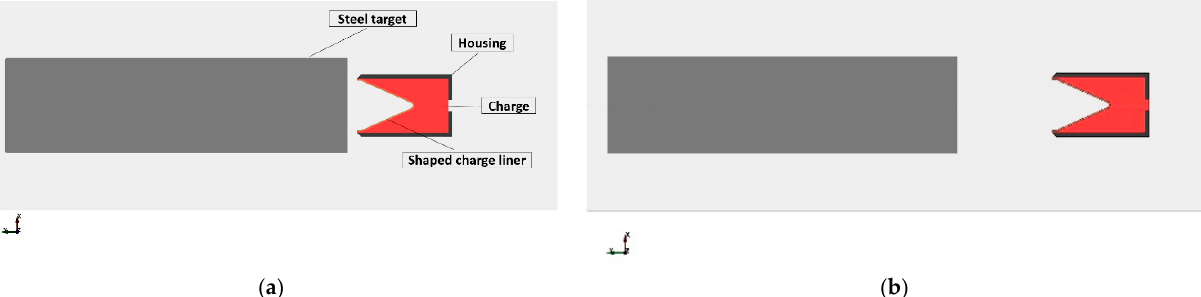
Figure 4. View of two variants of the shaped charge model: ( a ) charge closest to the target and ( b ) charge farthest from the target.